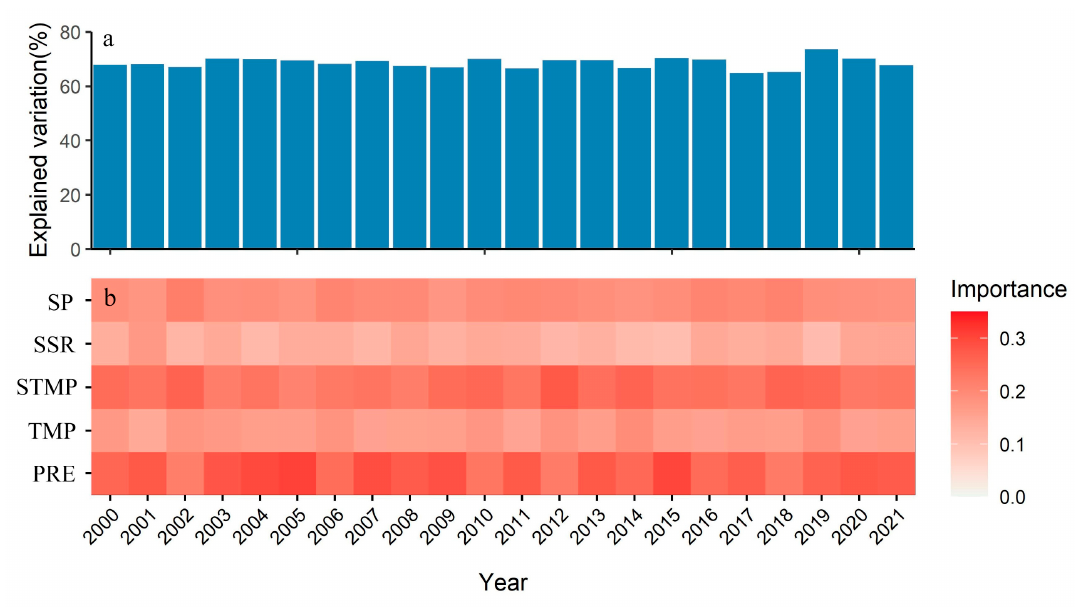
Figure 10. Importance evaluation based on the random forest model. The bar chart ( a ) shows the explanatory degree of the random forest regression model in the current year, and the colors ( b ) represent the